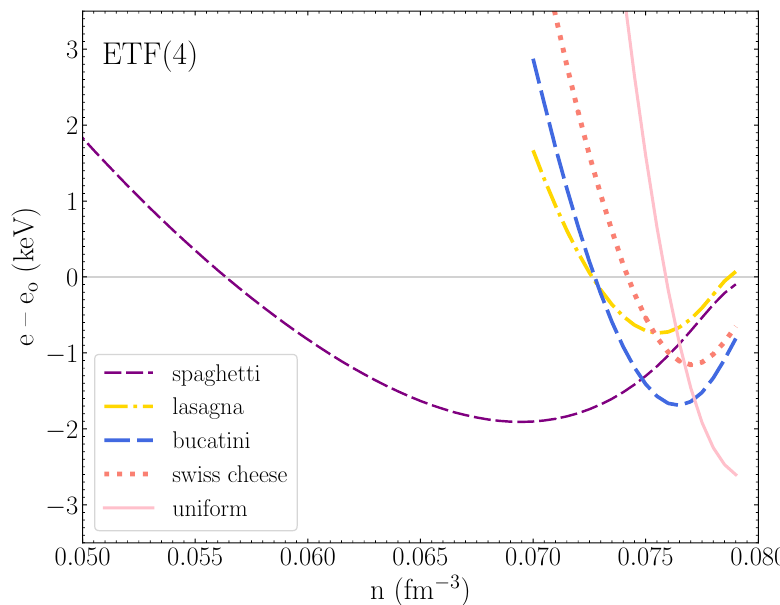
Figure 2. Difference in energy per nucleon between pasta phases and spheres versus baryon number density for ETF calculations. Thin violet and thick blue dashed lines represent spaghetti and bucatini, respectively; the yellow dash–dot line denotes lasagna; red dots map Swiss cheese; finally, the pink solid line is for uniform